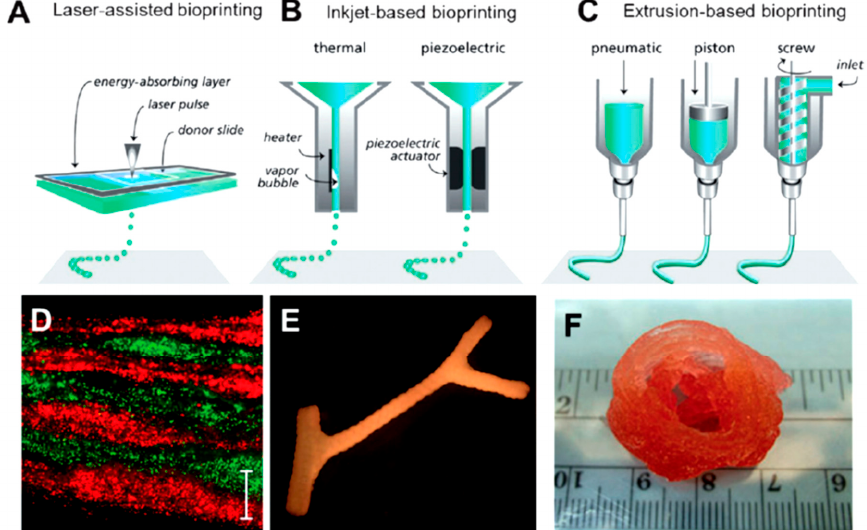
Figure 12. Main 3D bioprinting strategies: ( A ) laser-assisted; ( B ) injet-based and ( C ) extrusion-based. Examples of bioprinting tissues correspond to skin prepared by laser printing ( D ); branched vasculature obtained by inkjet printing ( E ) and heart aortic valve by extrusion bioprinting ( F ). Reproduced with permission from [194], copyright 2016 Wiley.